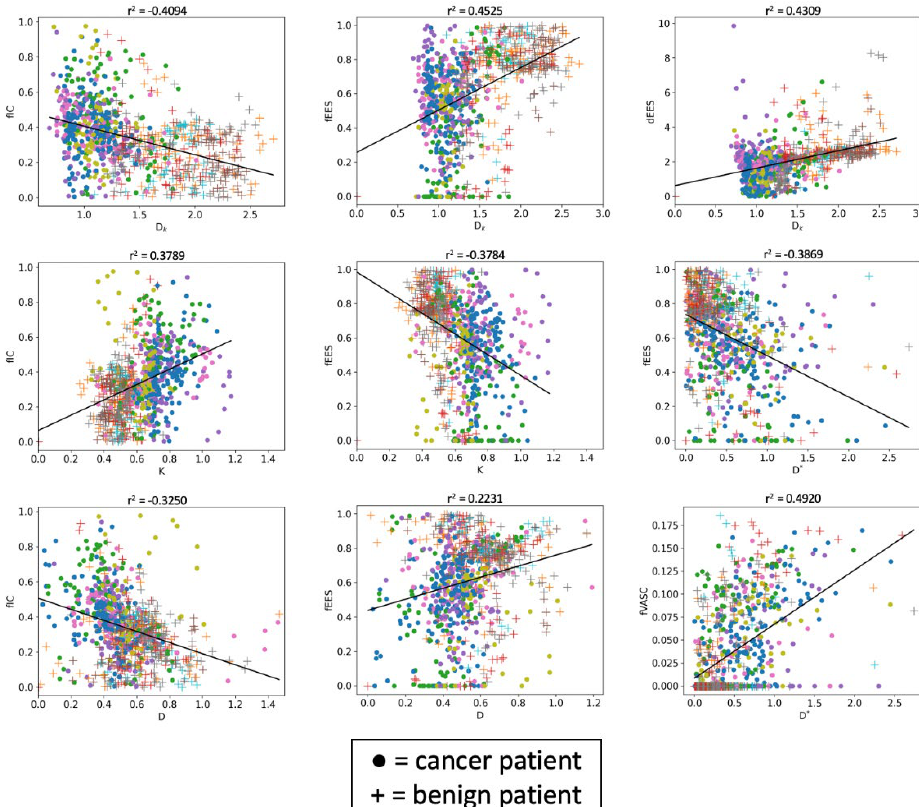
Figure 5. Scatter plots showing the correlation between VERDICT parameters and the DKI and IVIM parameters. For D K and D , we observed a negative correlation with f IC and positive correlation with f EES and d EES . K shows a positive correlation with f IC and negative correlation with f EES . Finally, D* shows a negative correlation with f EES and positive correlation with f VASC .